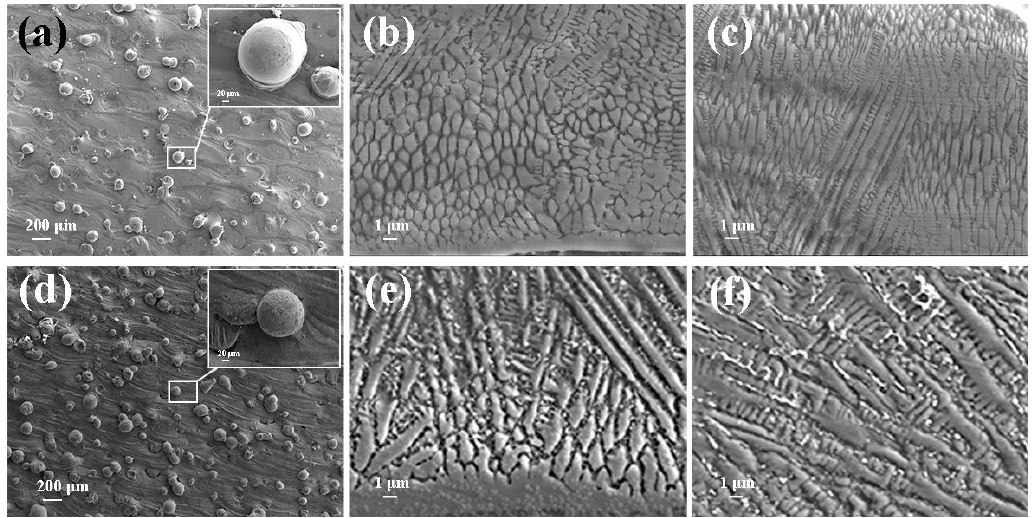
Figure 5. SEM image of the Inconel625 coatings prepared by UHSLC: ( a ) surface; ( b ) bottom; ( c ) top; SEM image of the Inconel625 coatings prepared by LSLC: ( d ) surface; ( e ) bottom; ( f ) top.